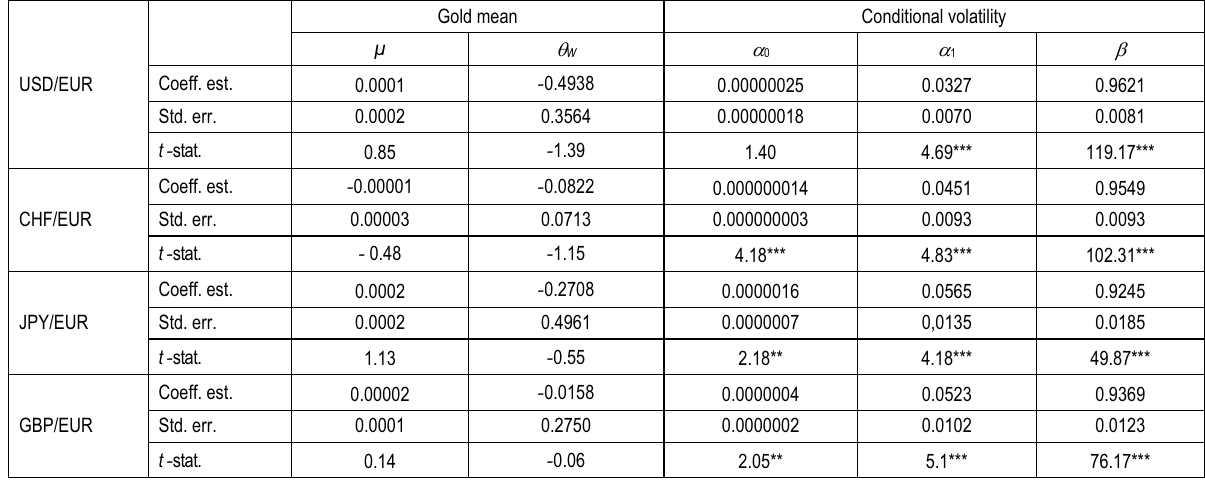
Table 6. Estimation results for Euro exchange rates – reverse causality test Results of GARCH-X (1,1) model with mean equation for exchange rate returns depending on gold’s